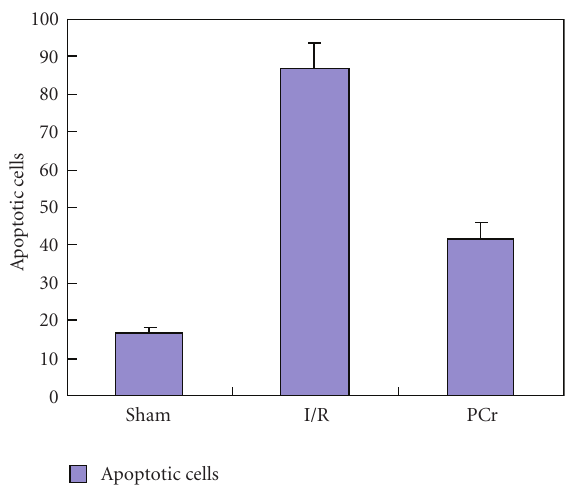
Figure 3: After we deal with the brain slices with an in situ cell- apoptosis-assay kit, we counted the number of apoptotic cells in each field.